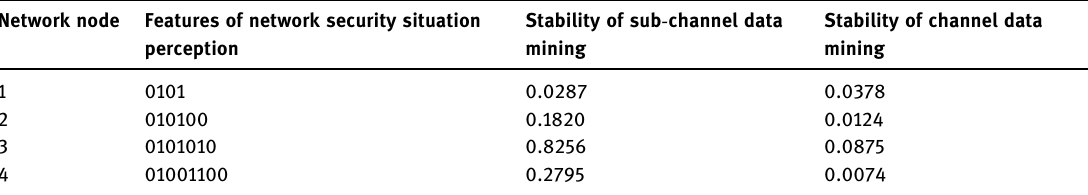
Table 1: Features of network security situation perception based on data mining Network node Features of network security